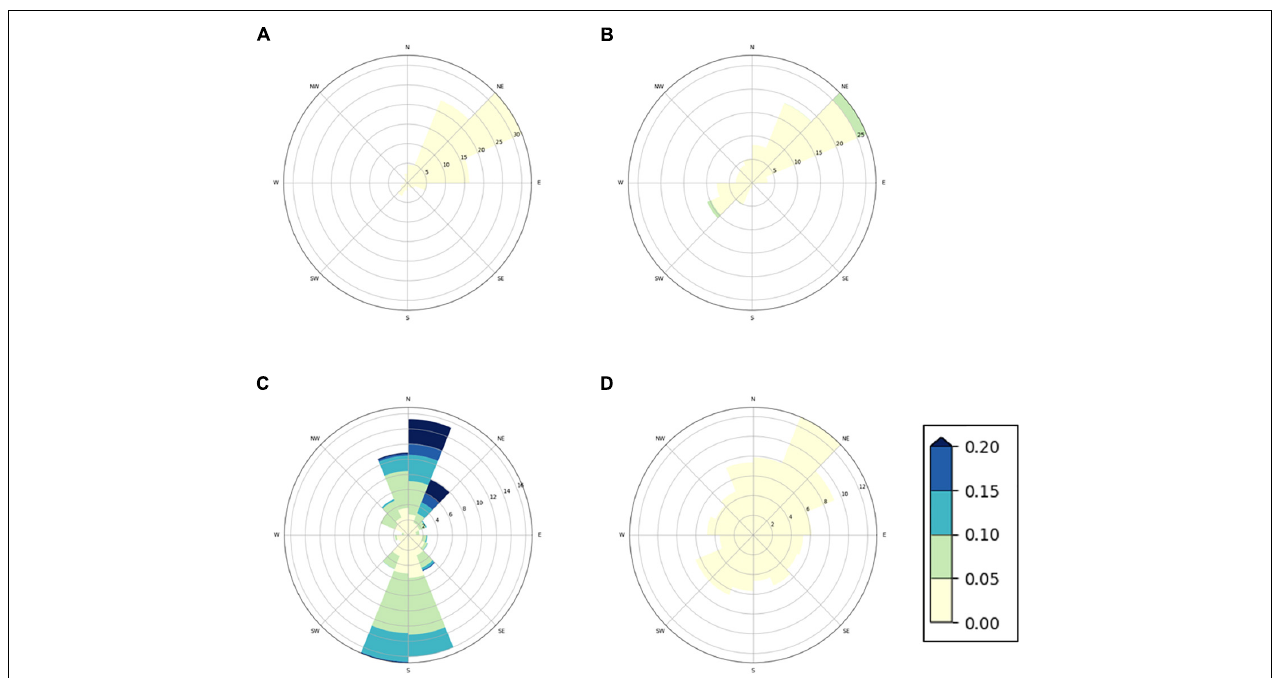
FIGURE 2 | Current rose distribution plots showing velocity, frequency, and direction of ocean currents simulated at four Norwegian fish farms. Simulated ocean currents are shown for (A) Farm A, (B) Farm B, (C) Farm C, and (D) Farm D at a depth of 30 m. The coloured bands show the strength of the current (m/s).